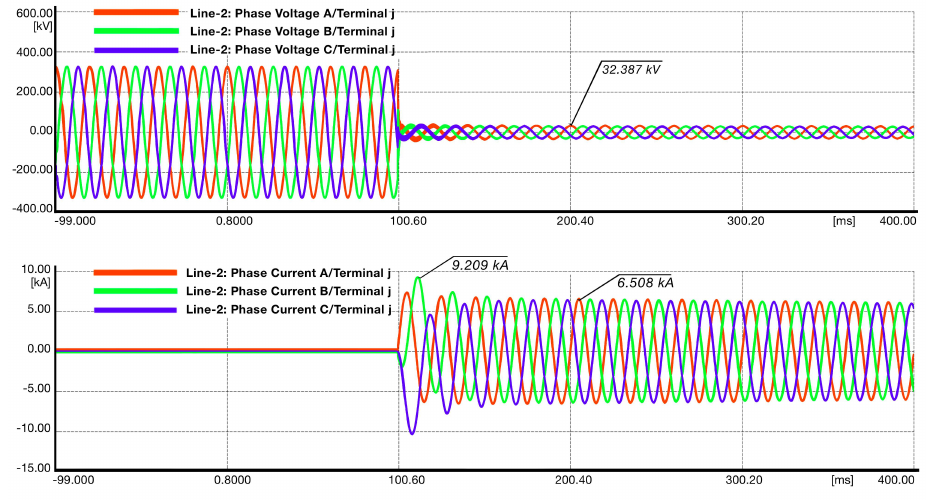
Figure 9. Three-phase voltages and currents for a three-phase